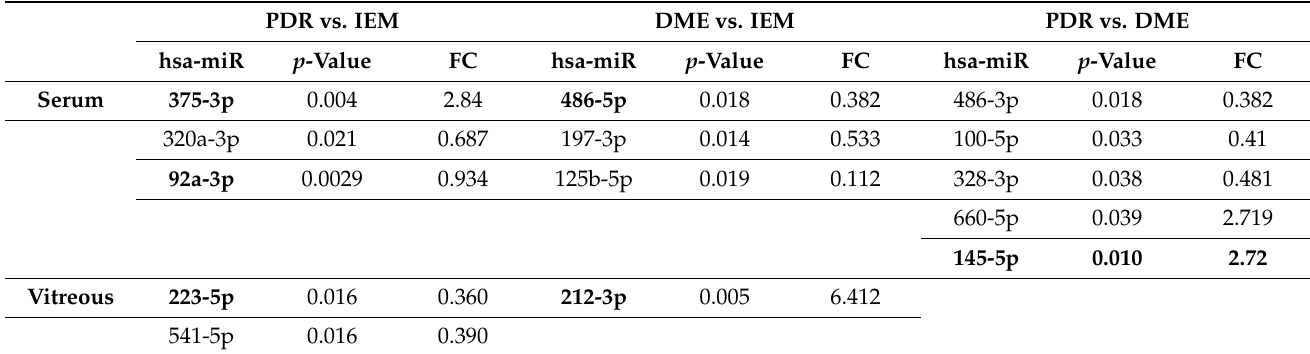
Table 2. Differentially expressed microRNAs in the serum and vitreous samples, obtained through